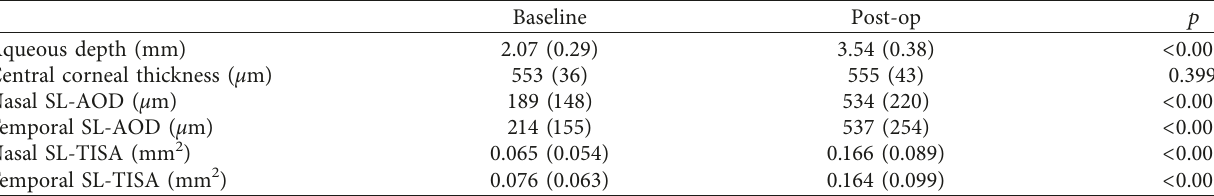
Table 2: Changes in anterior chamber ocular parameters.